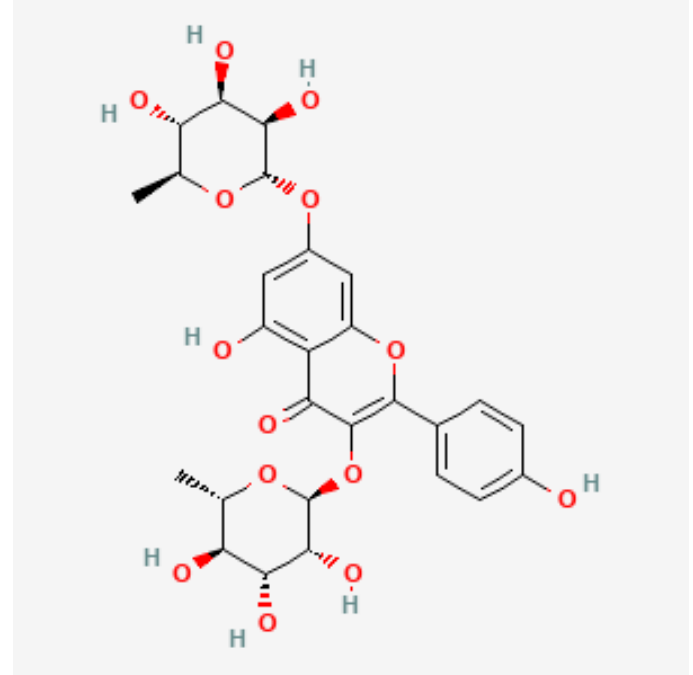
Figure 1. Chemical structure of kaempferitrin.